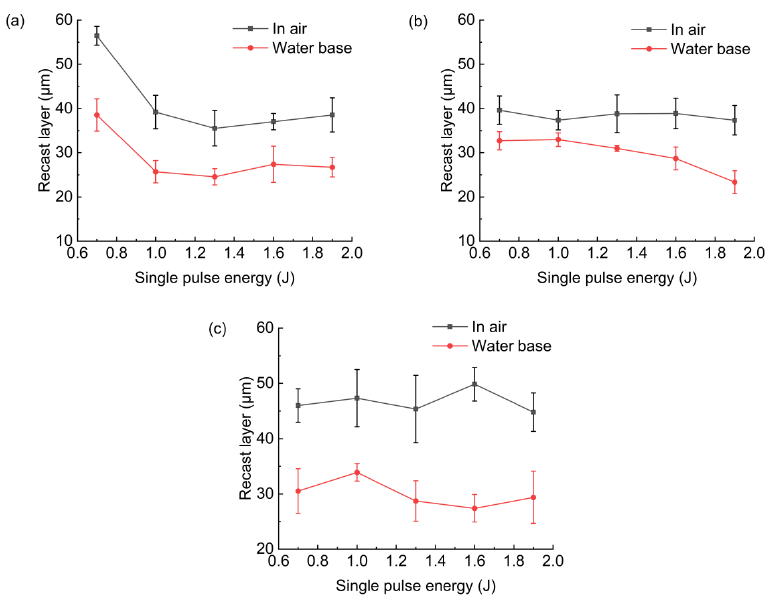
Figure 14. Effect of pulse energy on hole recast layer: ( a ) hole entrance, ( b ) hole middle, ( c ) hole exit.